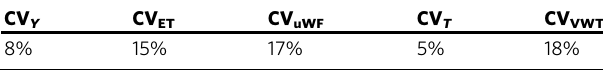
Table 1 Uncertainty of: yield (CV Y ), evapotranspiration (CV ET ), unit water footprint (CV uWF ), traded tons (CV T ), and traded virtual water volume (CV VWT ) estimates. CV Y CV ET CV